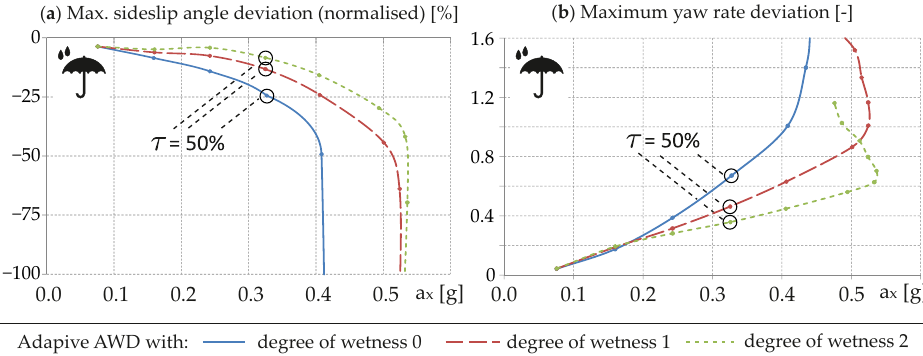
Figure 13. “Power On Cornering“ maneuver ( R = 60m , a y 0 = 6m/s 2 ) on wet road ( µ max = 0.6): ( a ) maximum to steady-state sideslip angle; ( b ) maximum to steady-state yaw rate. Even at low longitudinal accelerations of approx. a x ,1 s = 0.2 g (corresponds to τ ≈ 35%) the overshoot behaviour of the vehicle response. In the highlighted example at τ =